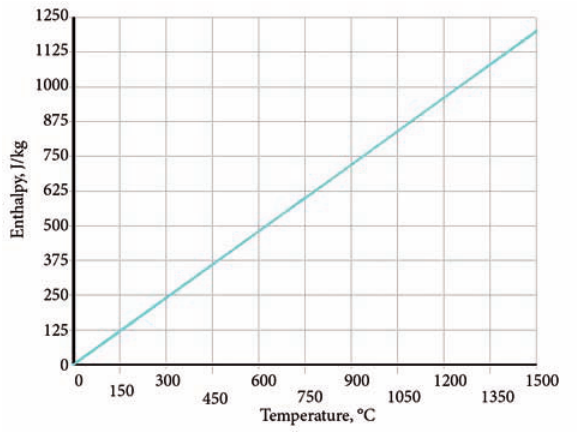
Fig. 5. Enthalpy reliance on temperature